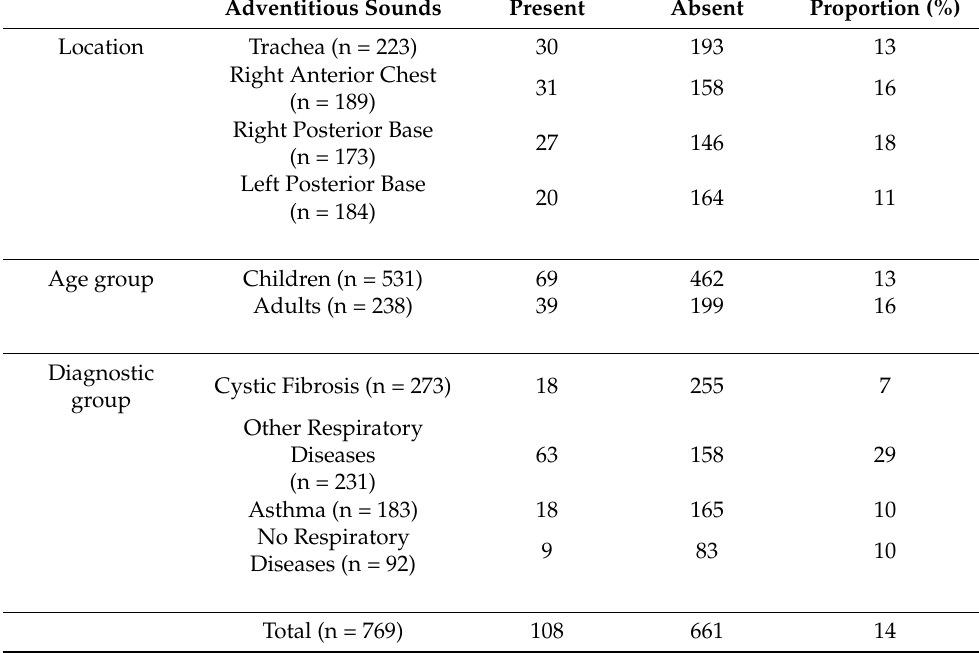
Table 3. Proportion of adventitious sounds by location, age group and diagnostic